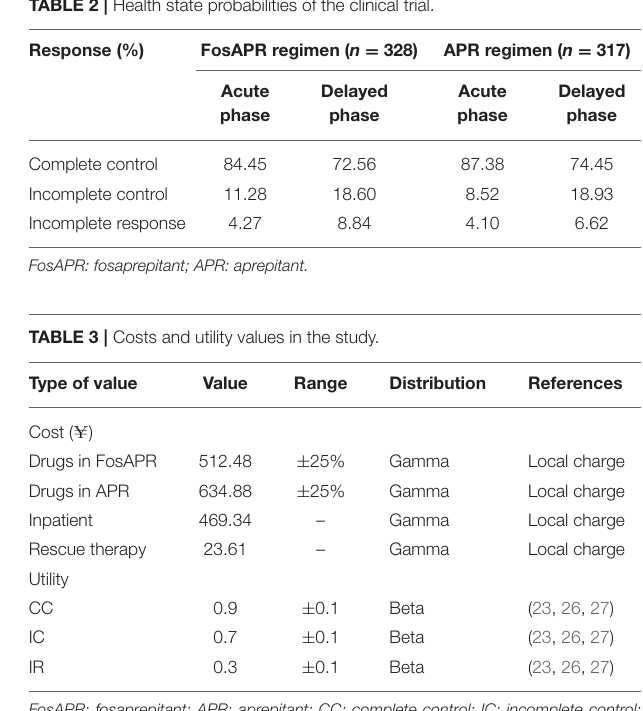
TABLE 2 | Health state probabilities of the clinical trial.